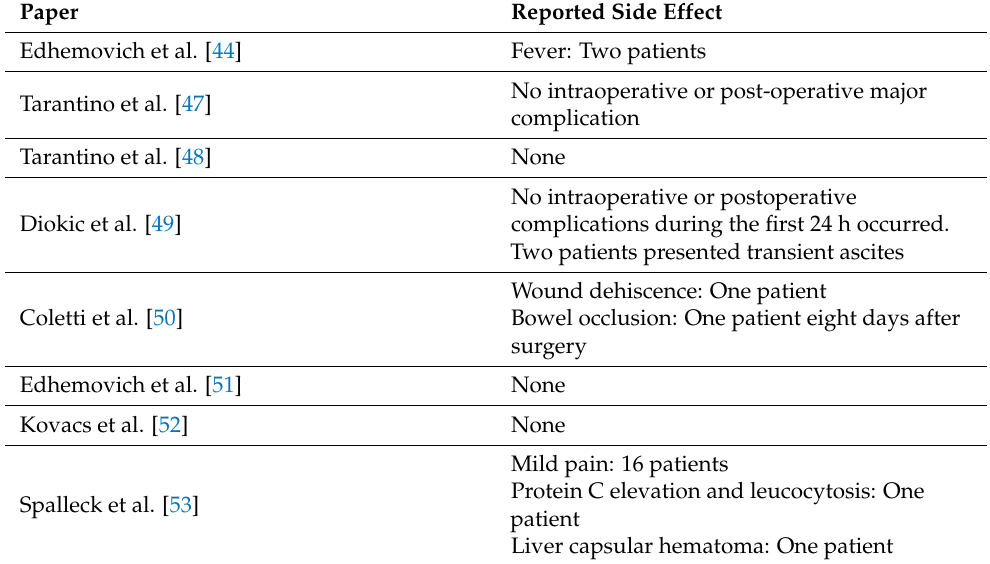
Table 2. Reported side effect for each